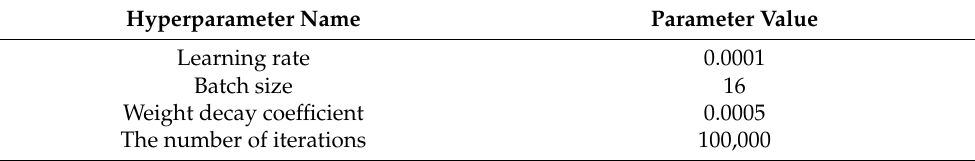
Table 3. Hyperparameter setting.